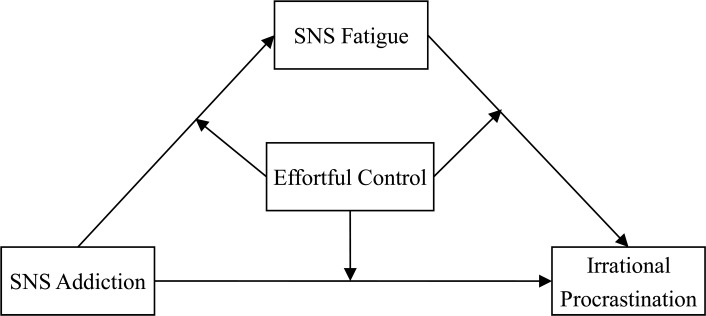
Conceptual model.